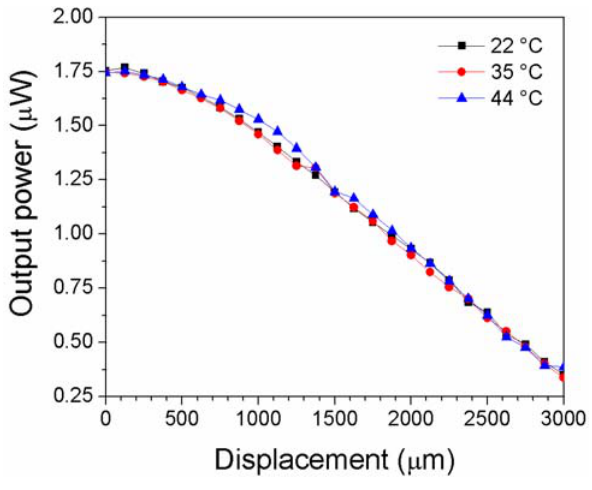
Figure 13. Output transmitted power as a function of displacement distance for a loop displacement sensor made with a 3 mm transition length, 30 mm waist length, and 35 μ m waist diameter of taper at three different